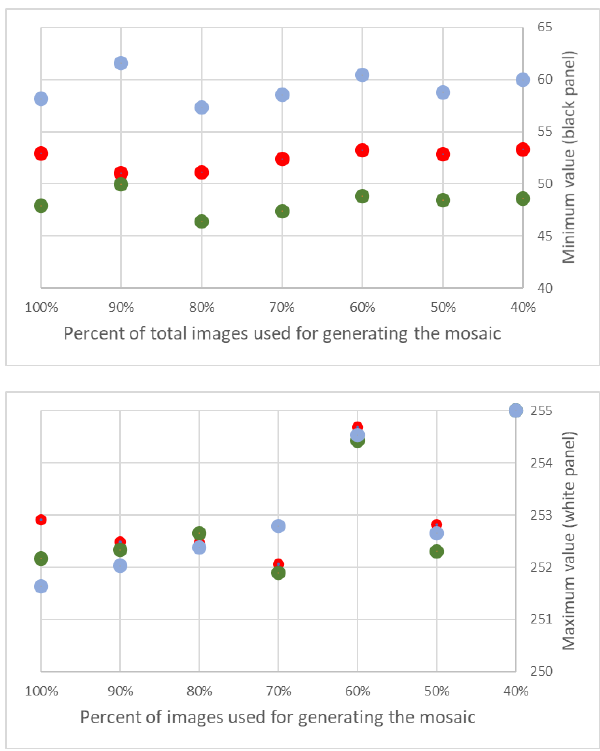
Figure 8 . Minimum, black panel (above) and maximum, white panel (below) values measured in the blue, green, and red bands (as colored dots) from the mosaics generated with different percent of aerial images acquired at 15